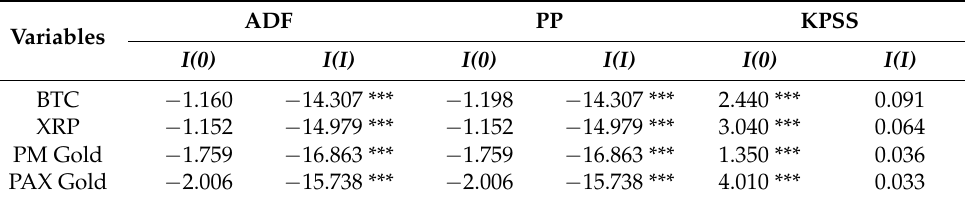
Table 3. Runs test.